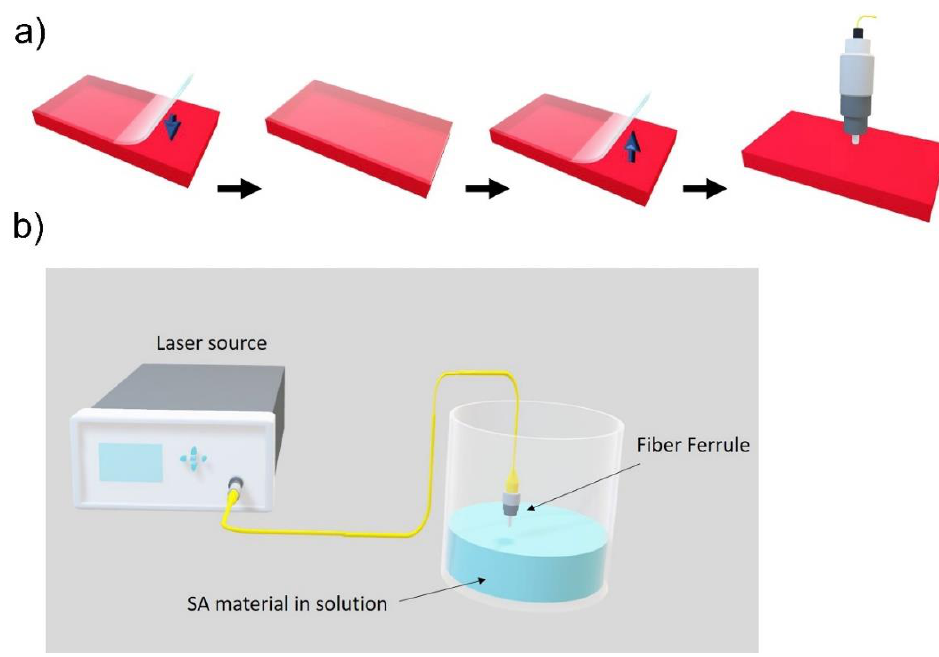
Figure 13. ( a ) Transferring a mechanically exfoliated few-layer flakes to fiber connecter. ( b ) Deposition of SA material onto the optical fiber ferrule based on optical driven deposition technique.